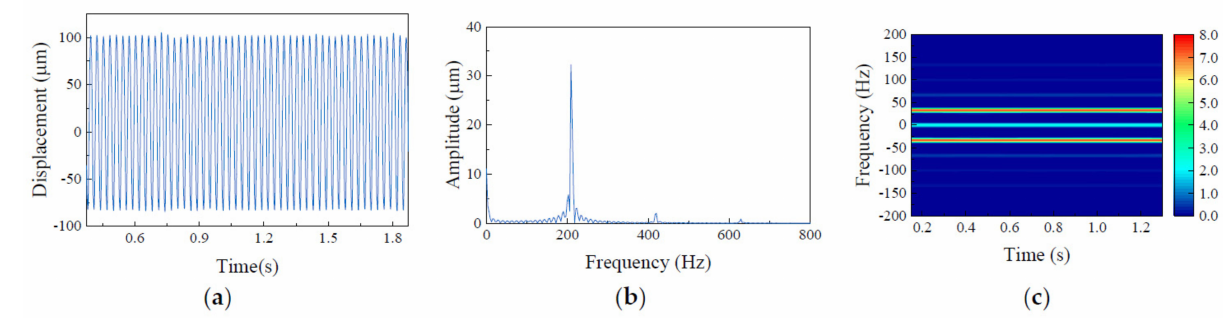
Figure 25. Comparison of fault signal processing results: ( a ) time domain diagram; ( b ) frequency domain diagram; ( c ) time − frequency diagram.